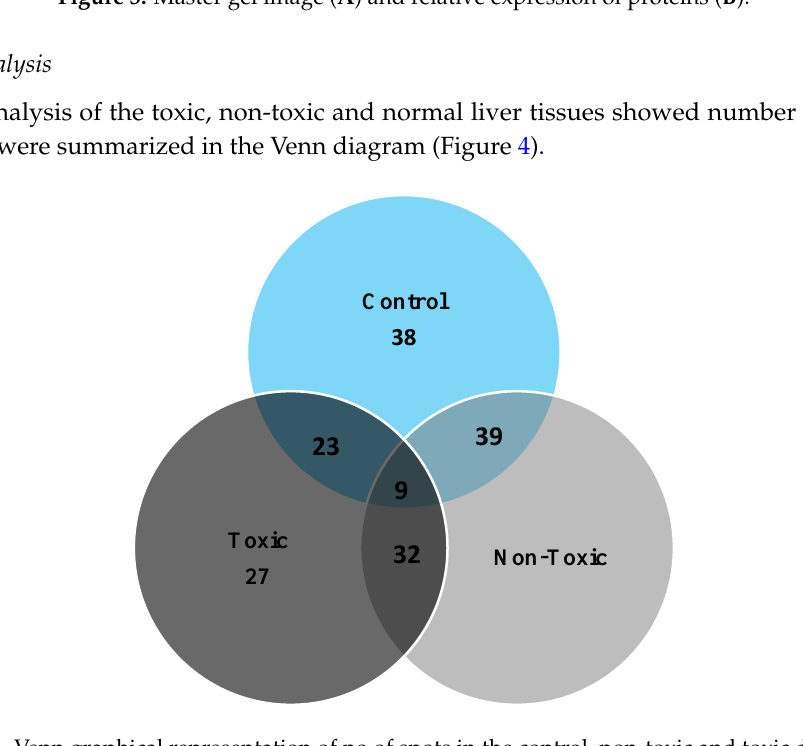
Figure 3. Master gel image ( A ) and relative expression of proteins ( B ).